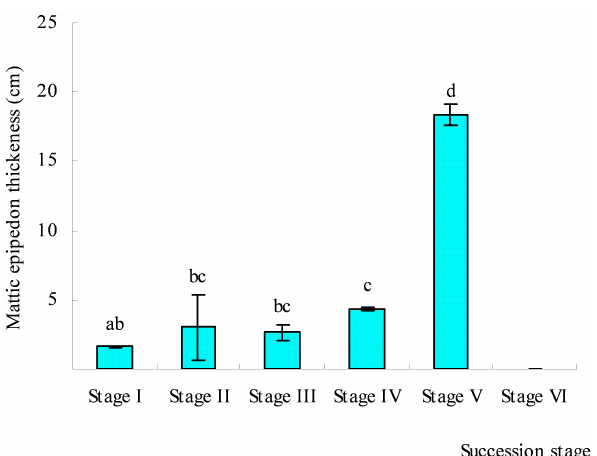
Figure 5. The thickness of mattic epipedon over the course of suc- cession. The values represent the means ± 1SD of four replicates. Different letters in the figures indicate significant differences be- tween stages at P <0.05. The stage details refer to Fig. 2.